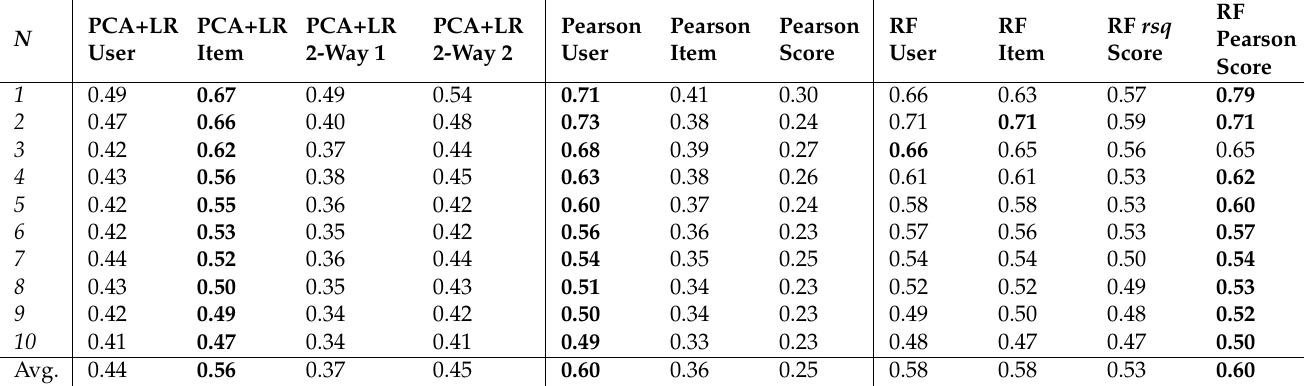
Table 5. Top- N accuracy for case